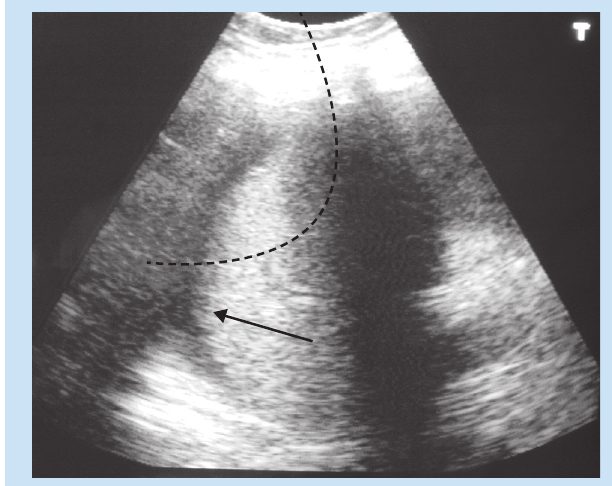
Fig. 1. Longitudinal ultrasound of the right upper quadrant showing cres- centic collection (arrow) in the right subphrenic space. Dashed line show- ing approximate needle path.